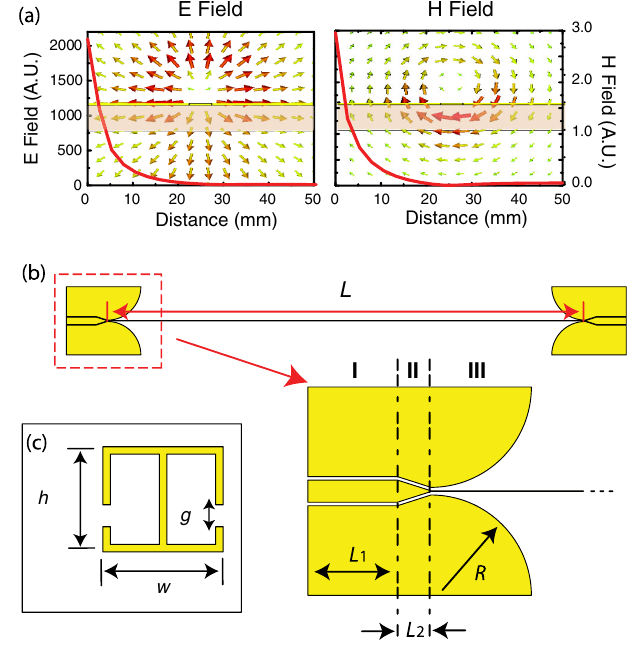
FIG. 1. Simulated modes and dimensions of the planar Goubau line, and metamaterial schematic. Left panel of (a) plots the norm of the electric field strength as a function of horizontal distance away from the center of the GHz PGL. Right panel of (a) plots the norm of the magnetic field in the same manner. Vector plots of the electric (left) and magnetic (right) field vectors are shown as the insets of Fig. 1(a). The very small gray rectangle at the center of each inset illustrates the cross section of the PGL. The larger rectangle is a cross sectional view of the supporting substrate. Panels (b) and (c) show the dimen- sions of the PGL and metamaterial,